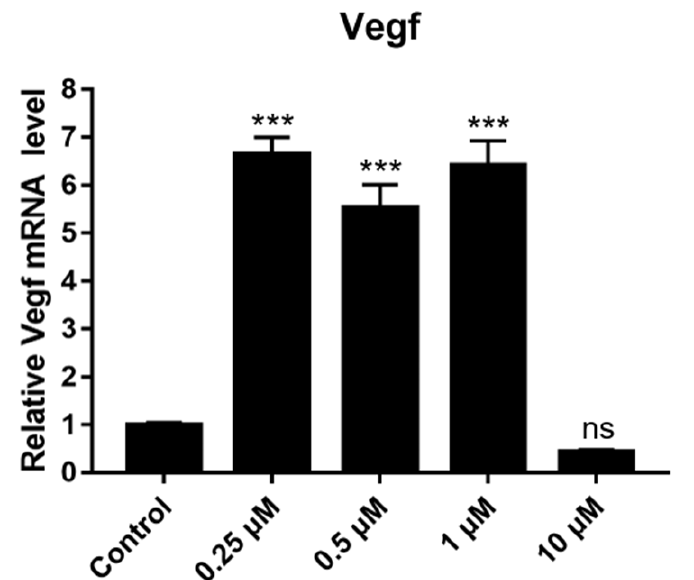
Figure 10. Effects of different concentrations of DSF on the relative mRNA expression of VEGF . *** p < 0.001, ns p > 0.05.